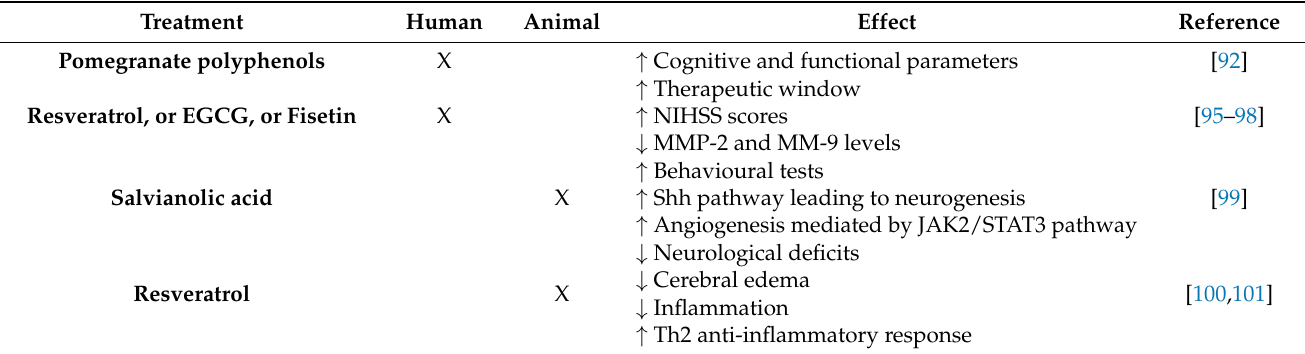
Table 2. Polyphenols-mediated beneficial outcomes and pathways following Ischemic Stroke.